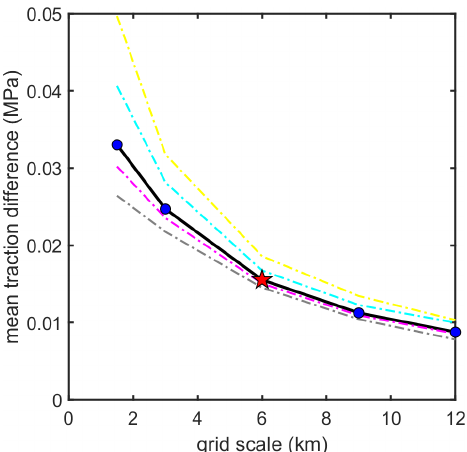
Figure 2. Mean traction difference (magnitude of SIA minus SSA) between the SIA and SSA approximation of basal traction as a function of grid scale. Decreasing difference indicates the effect of higher-order stresses decreases with increasing grid length. Red star shows 6km grid scale which is the primary grid scale used for our analysis. Dashed lines show same analysis for different subsets of the data (margin regions < 1200ma.s.l. – yellow line, interior regions > 1200ma.s.l. – grey line, thickness > 1500m – magenta line, thickness < 1500m – cyan